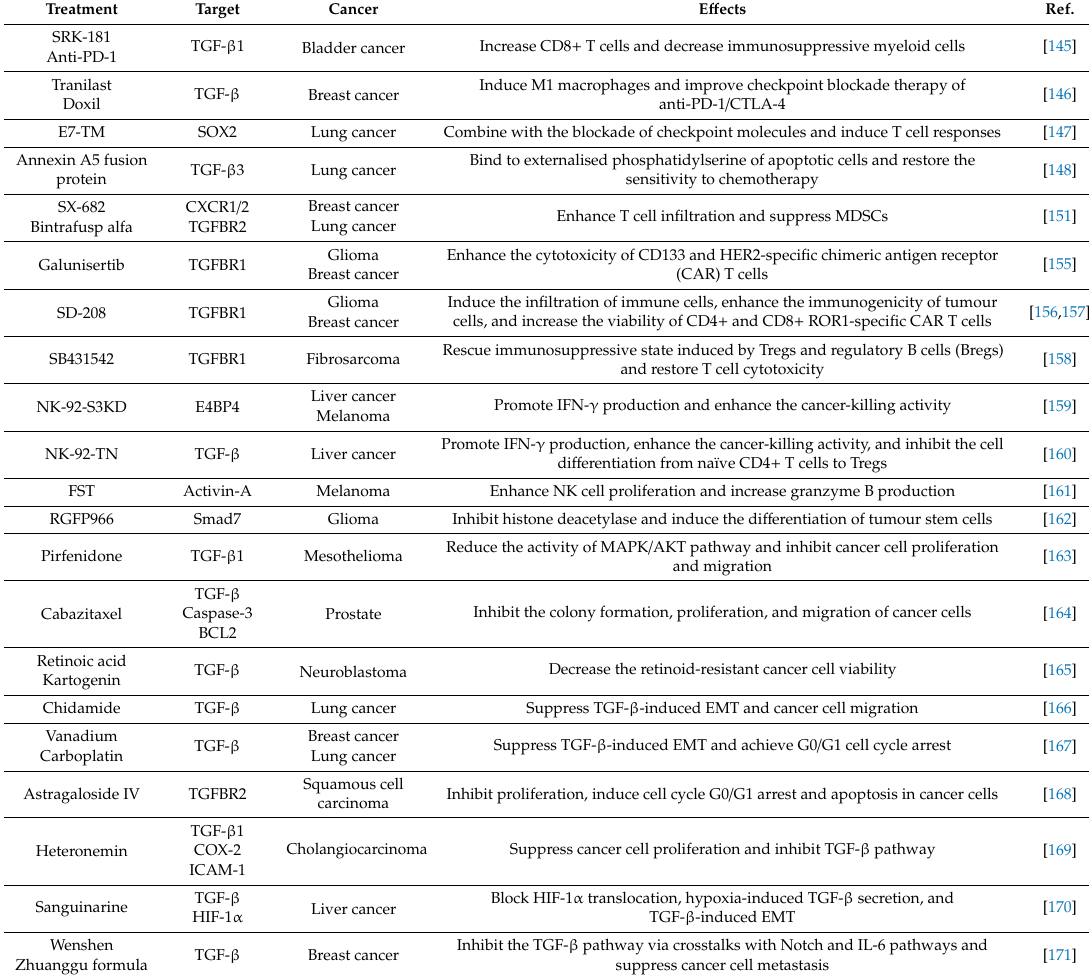
Table 2. Cancer immunotherapeutic strategies based on the regulation of the TGF- β pathway.